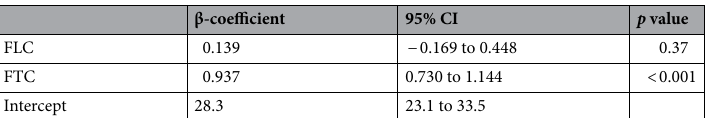
Table 2. Multiple regression analysis of FLC and FTC (dependent variable: RVEF). CI Confidence interval, RVEF Right ventricular ejection fraction, FLC Fractional longitudinal change, FTC Fractional transverse